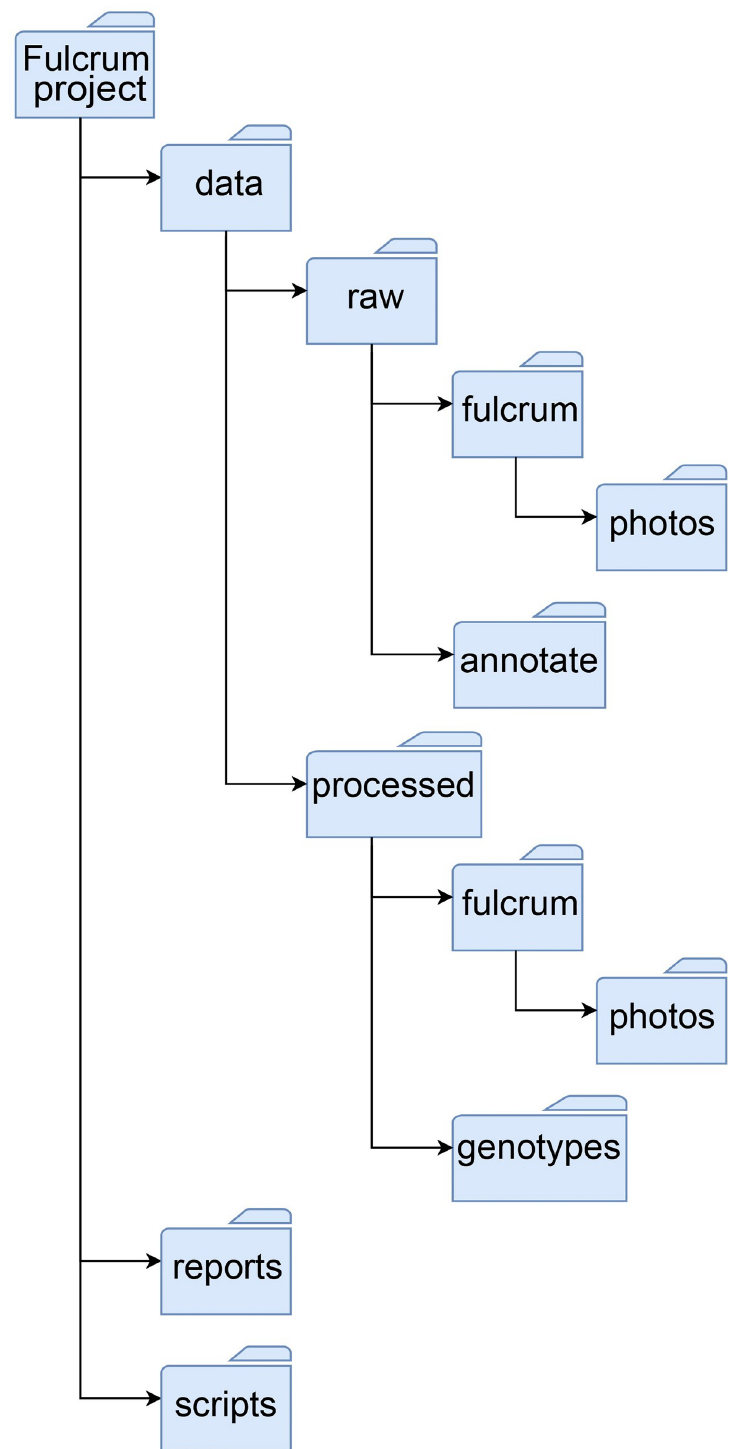
Fig 2. easyFulcrum directory structure. The makeDirStructure() function will produce the directory structure shown above. In this directory structure, the data folder represents the main subfolder containing both raw and processed Fulcrum data. The data/raw/fulcrum subfolder contains the five raw comma-separated value csv files exported from the Fulcrum website and the data/raw/fulcrum/photos subfolder contains the exported photos in jpg format (see Methods, Fulcrum data export) files exported from Fulcrum. The data/raw/annotate subfolder can be used to hold